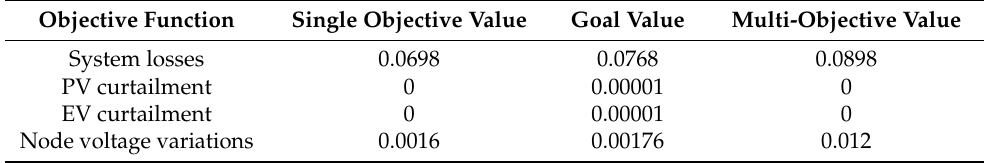
Table 5. Optimal values for single objectives and the multi-objective for Case